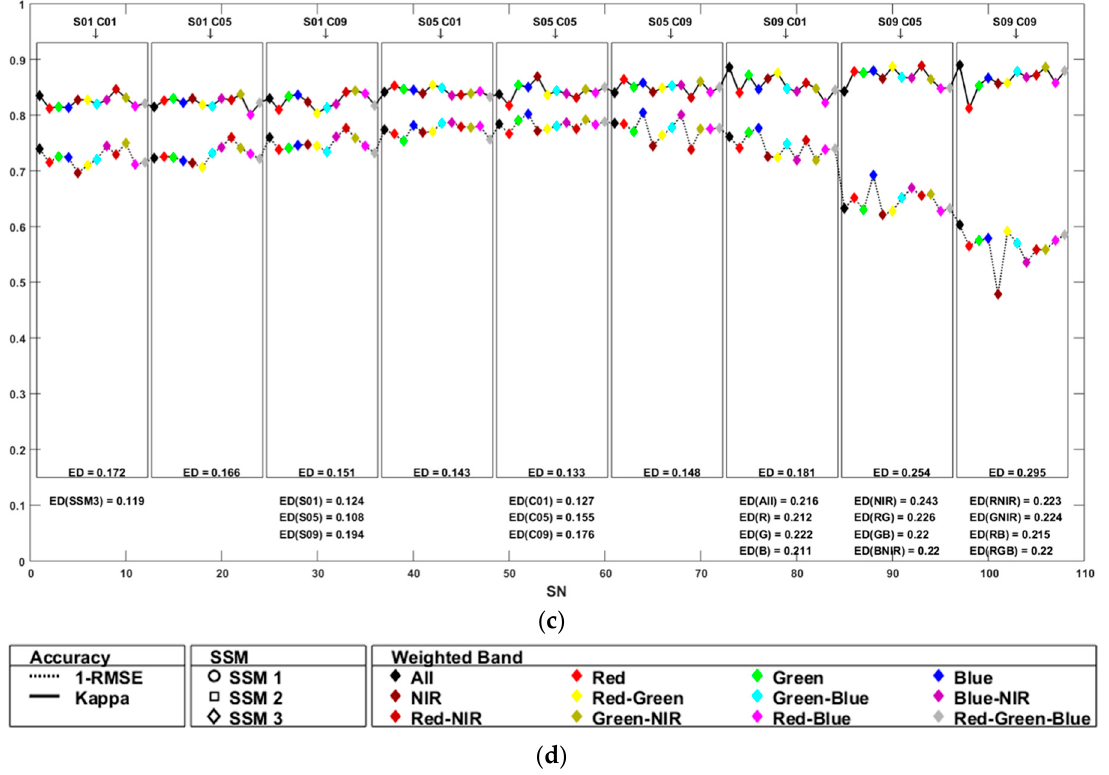
Figure 17. Classification kappa values and segmentation RMSE values according to segment selection method, shape and compactness criteria and Euclidean distances ( a ) SSM 1, ( b ) SSM 2, ( c ) SSM 3, and ( d ) legend.